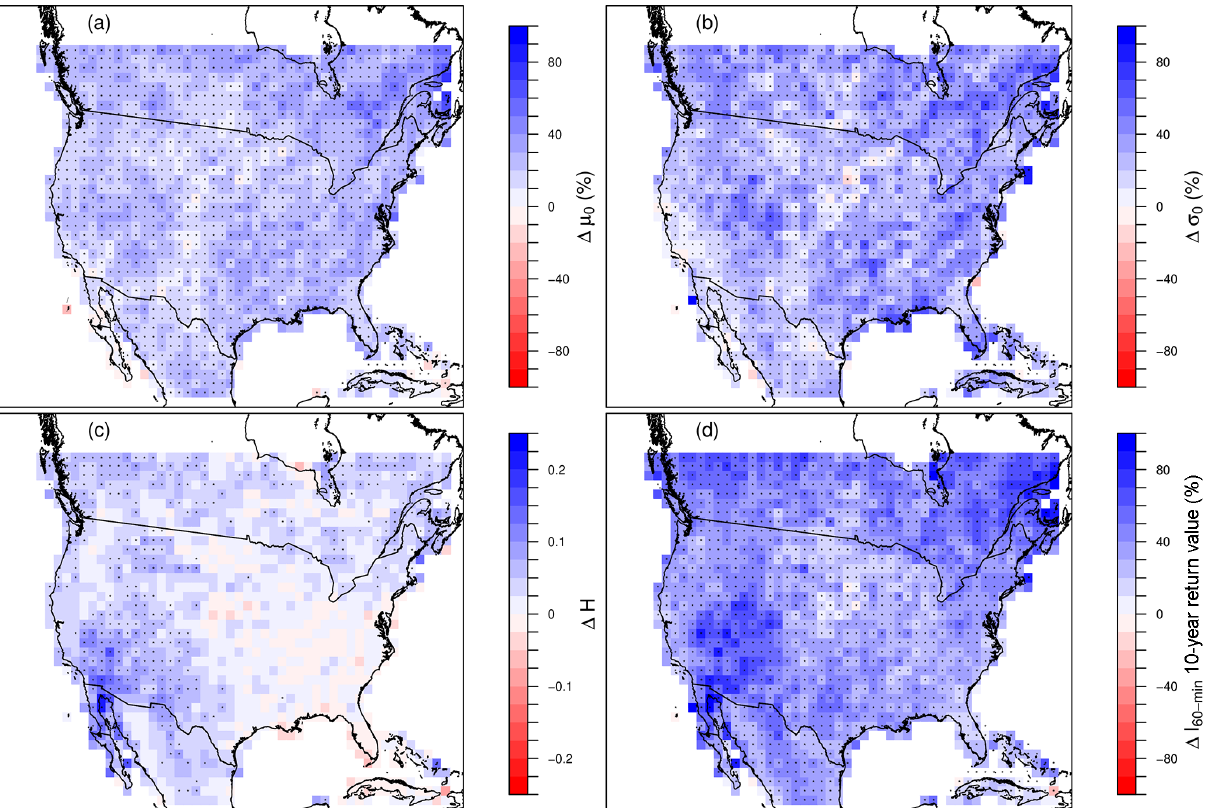
Figure 9. Projected changes in GEVSS (a) location µ 0 , (b) scale σ 0 , and (c) scaling exponent H parameters, as well as changes in (d) 10- year return level 1h duration rainfall extremes I 60min , 10years . For ease of visualization, results are aggregated to a 100km × 100km grid. Values shown are aggregated grid box means; boxes in which more than half of the 4km WRF grids show significant increases (decreases) are marked with a ∗ ( /